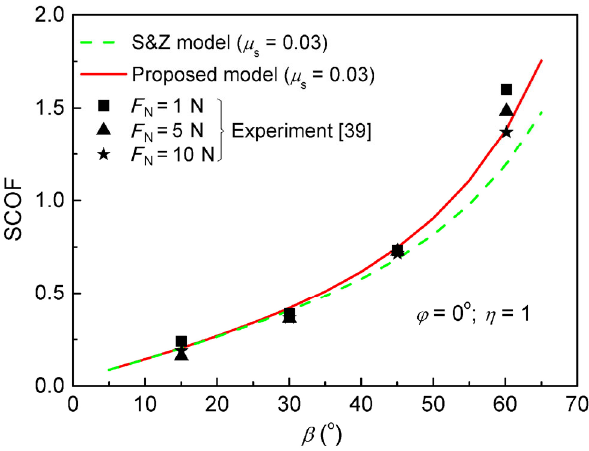
Fig. 5 SCOFs with a zero-recovery angle as a function of 